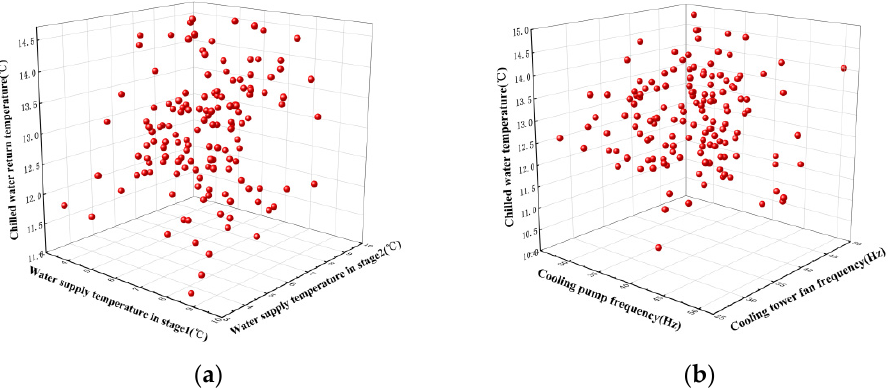
Figure 8. Sample distribution diagram of different parameter combinations. ( a ) Stage 1 and 2 water supply temperature and chilled water return temperature; ( b ) Cooling pump frequency, fan frequency, and chilled water return temperature.